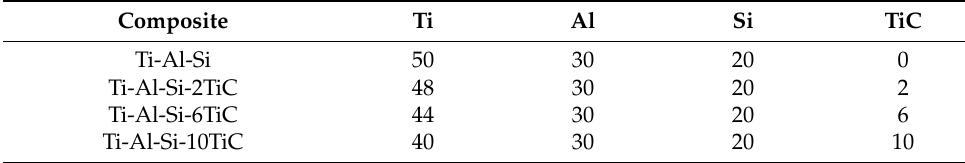
Table 1. Compositions of Ti-Al-Si- x TiC composites (wt.%). Composite